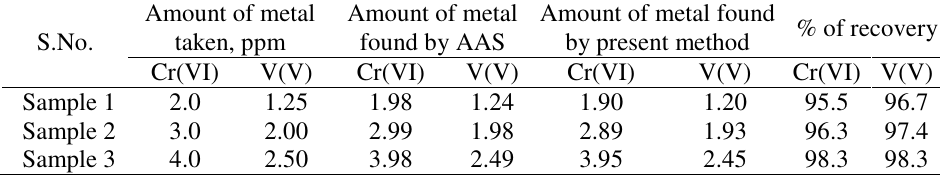
Table 3. Simultaneous determination of chromium(VI) and vanadium(V) in synthetic mixtures. Amount of metal Amount of metal taken, ppm found by